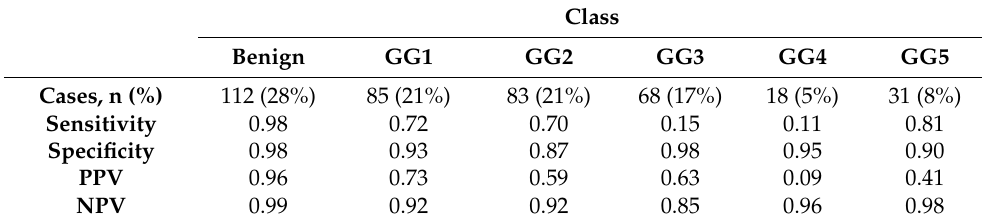
Table 6. Accuracy of the AI algorithm: Predictive values for dichotomized groups.